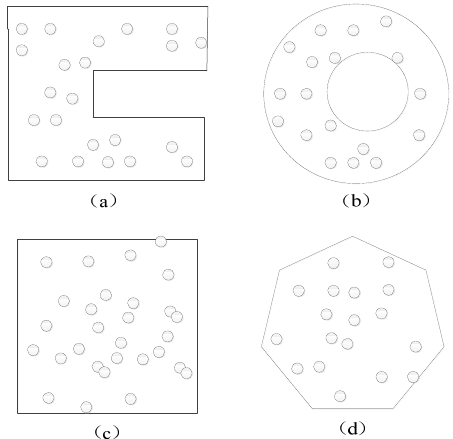
Figure 1. Comparison diagram of concave and convex areas. ( a , b ) are concave regions; ( c , d ) are convex regions. convex